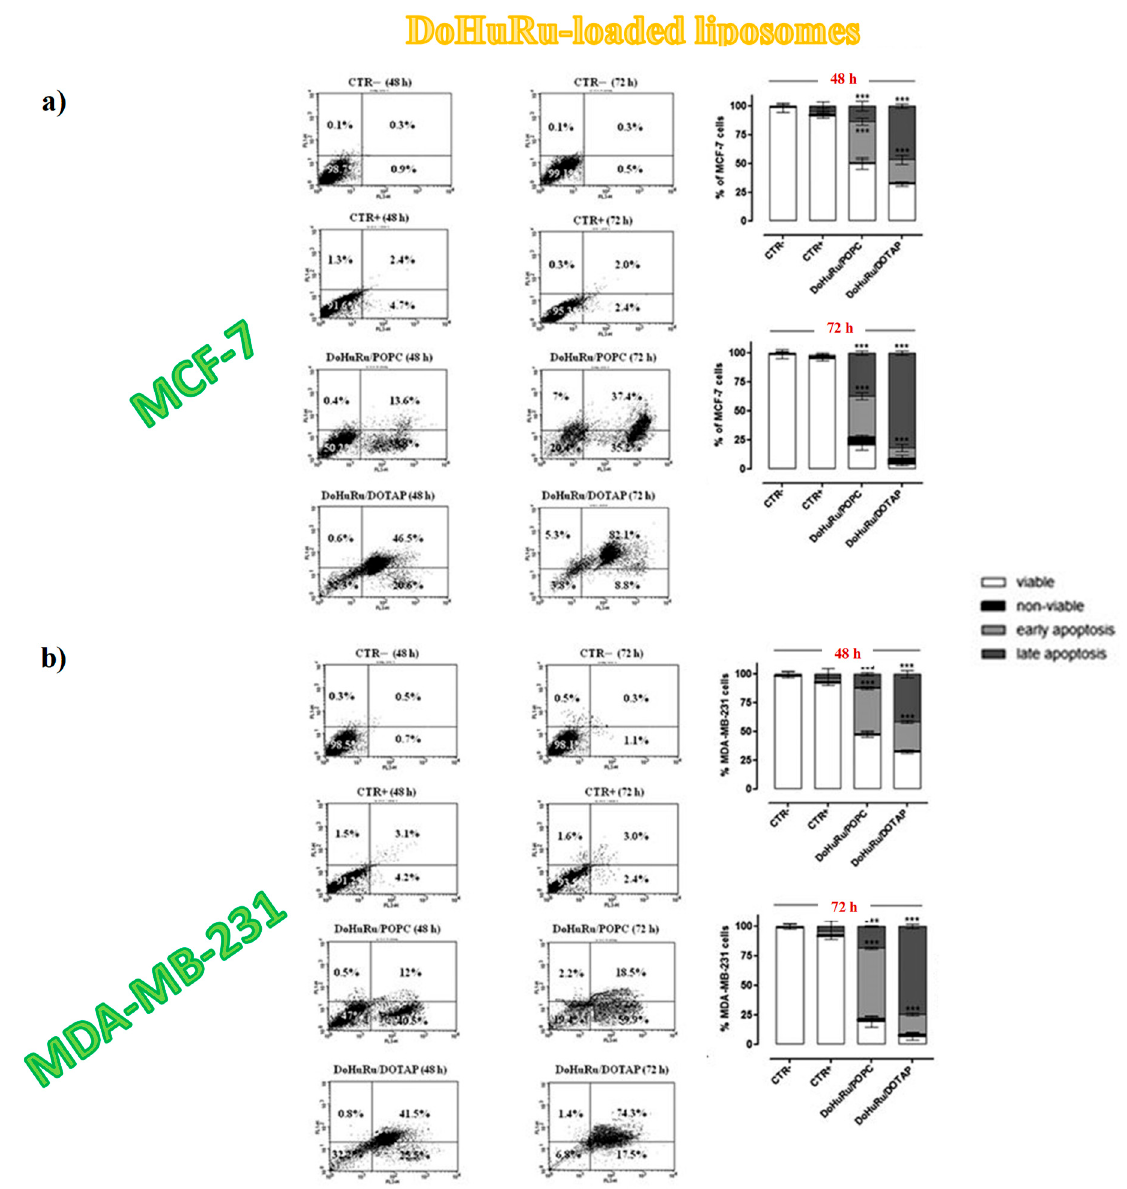
Figure 10. Induction of apoptosis in MCF-7 ( a ) and MDA-MB-231( b ) breast cancer cells, evaluated by FACS analysis (right on each panel), after cell labelling with propidium iodide (PI) and FITC-Annexin V. Cells were both unlabelled and untreated (CTR − ), labelled and not treated (CTR + ), treated with IC 50 doses of DoHuRu-incorporating POPC or DOTAP liposomes for 48 and 72 h, as indicated. The quantitative analysis of viable, non-viable (necrotic), early and late apoptotic cells after drug exposure is represented (bar graphs on the right of each panel). Viable cells are negative for both PI and FITC-Annexin V binding; non-viable, necrotic cells are negative for FITC-Annexin V binding and positive for PI uptake; cells in early apoptosis are FITC-Annexin V positive and PI negative; cells in late apoptosis are positive for both FITC-Annexin V binding and PI uptake. Figures were adapted from [134].